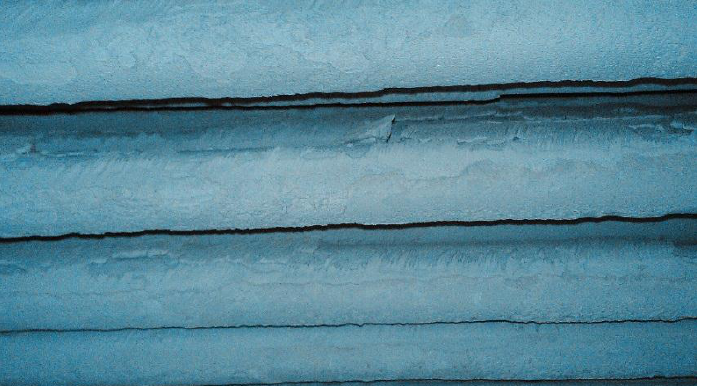
Figure 3. Slagging on the superheater.